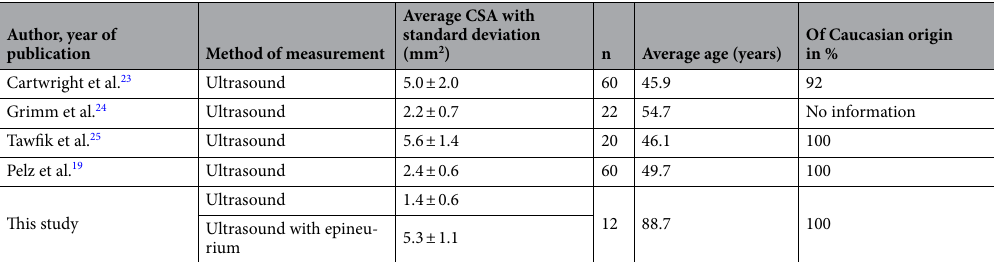
Table 2. Cross-sectional area (CSA) of the cervical vagus nerve (CVN) varies in different publications. From Tawfik et al. 25 only the group of healthy controls are given. The sample size is indicated by